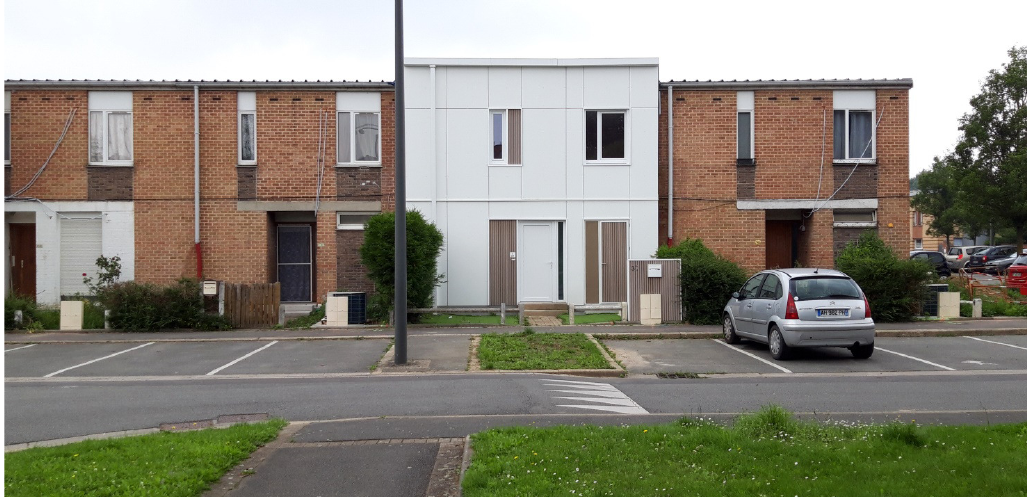
Figure 1. A prefabricated facade for a renovated house in